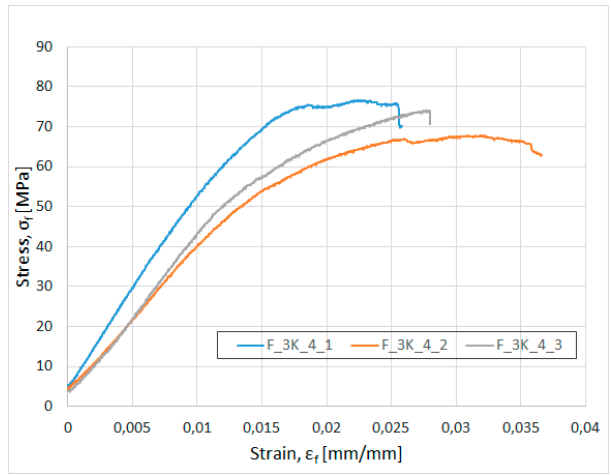
Figure 11. Results of three-point bending test for 3K yarn with four layers (c) the authors, CC BY-NC-ND 4.0 [17].